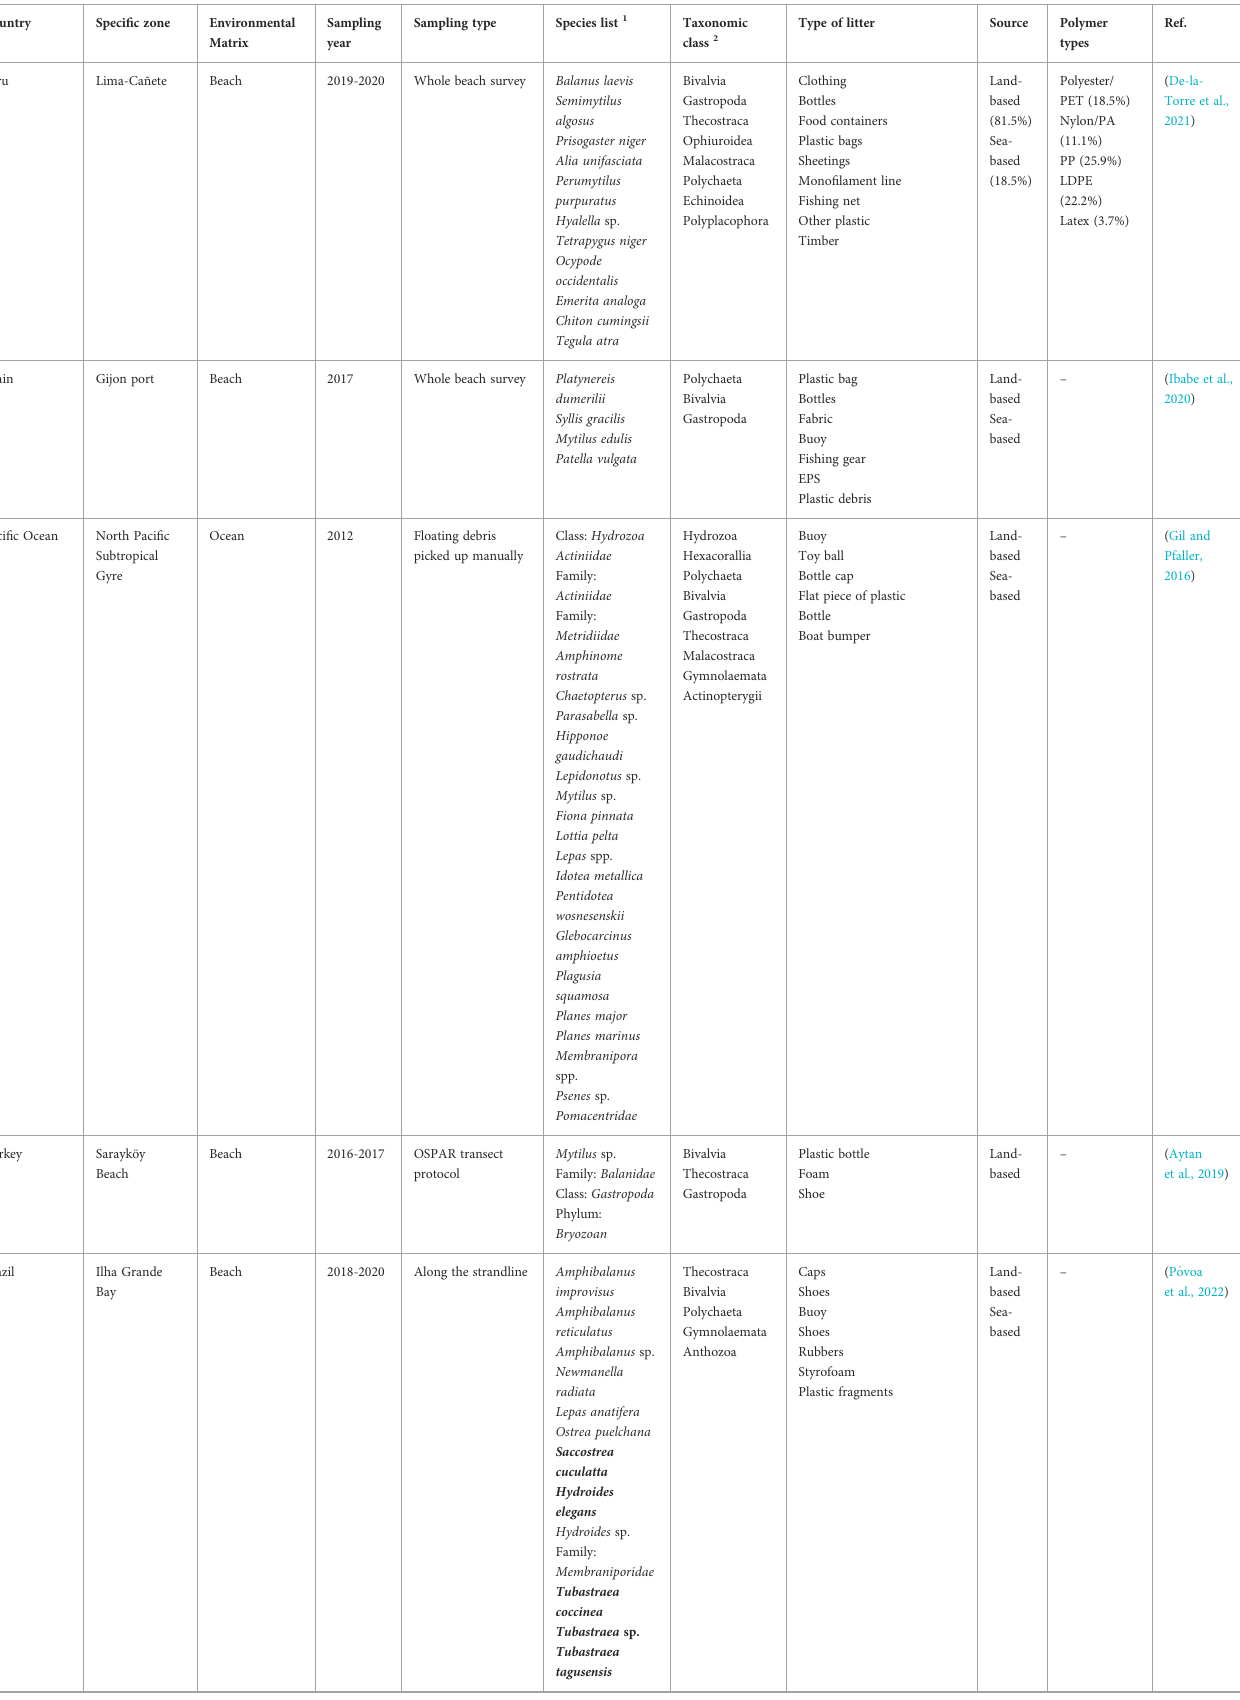
TABLE 1 Characteristics of methodologies and results of the 39 studies